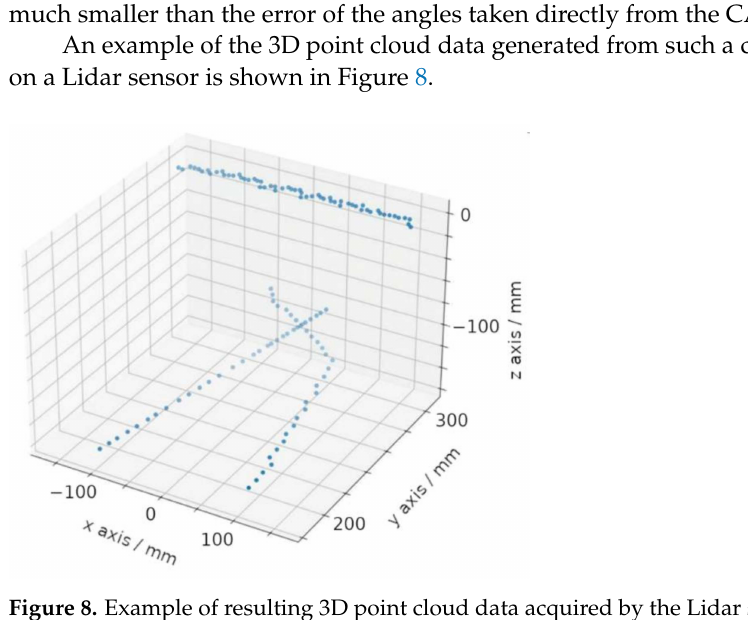
Figure 8. Example of resulting 3D point cloud data acquired by the Lidar sensor with two mirrors. The prototype vehicle had a flat wall in front for the data acquisition. Data points on this wall, as well as on the floor surface can be